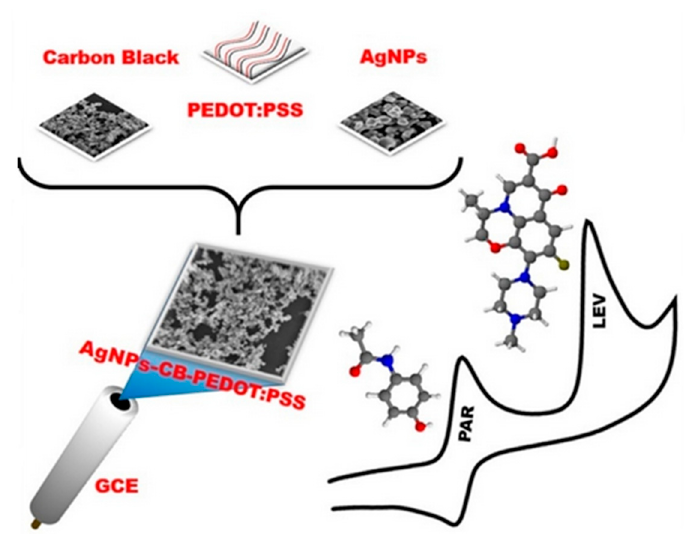
Figure 5. Assembly scheme of a GCE / AgNPs-CB-PEDOT:PSS sensor used for simultaneous determination of acetaminophen and levofloxacin (reproduced from [141], with permission from Elsevier, 2017).